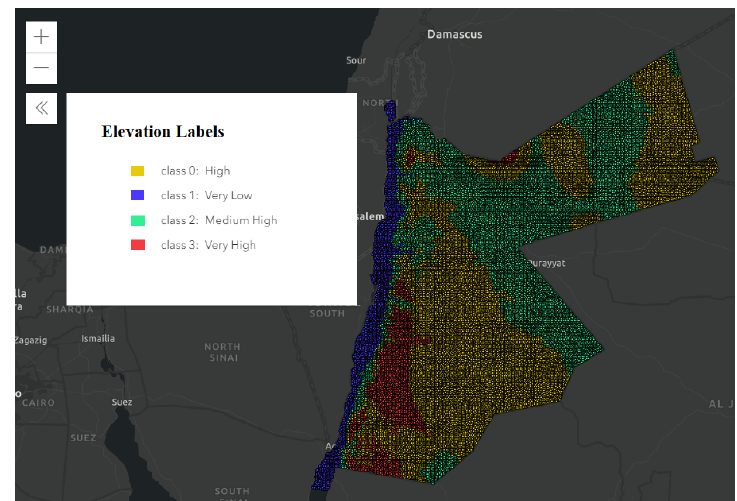
Figure 8. Elevation clustering in Jordan with k = 4.